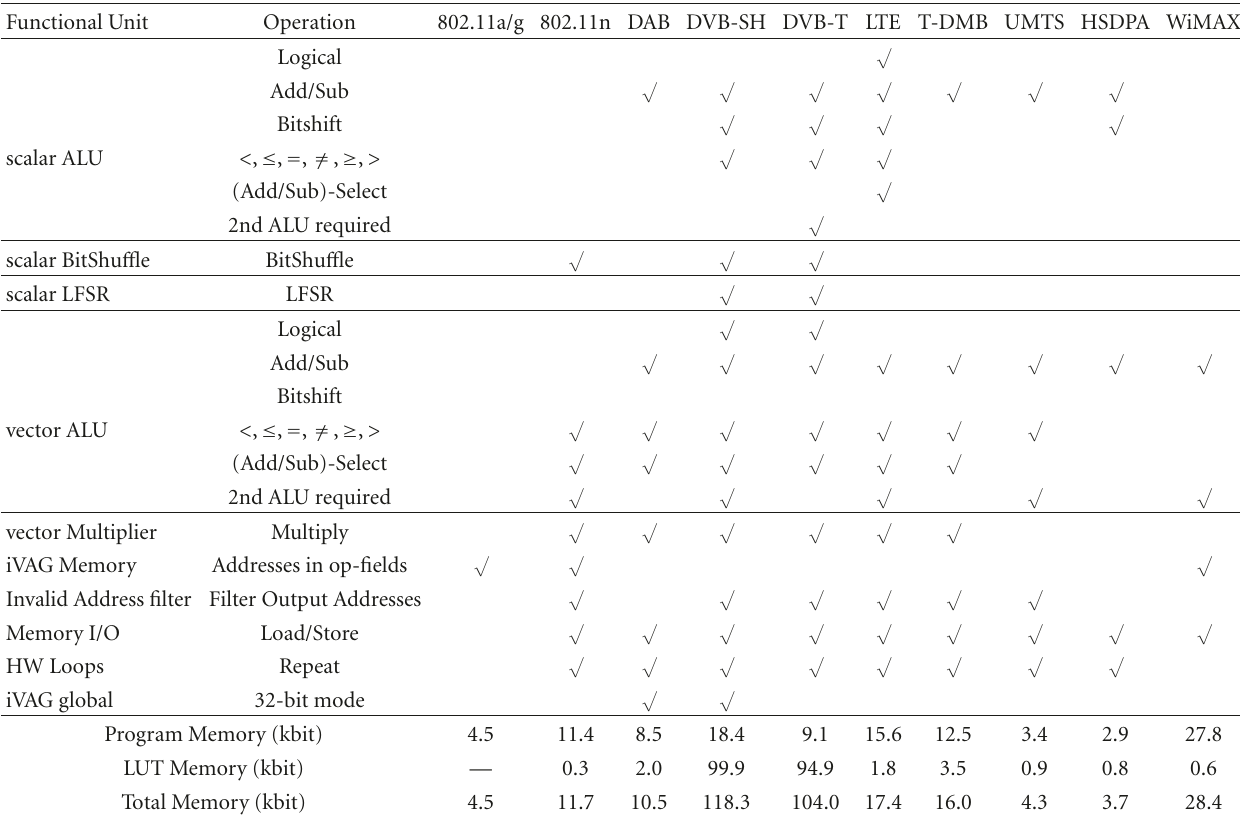
Table 8: iVAG operations usage.